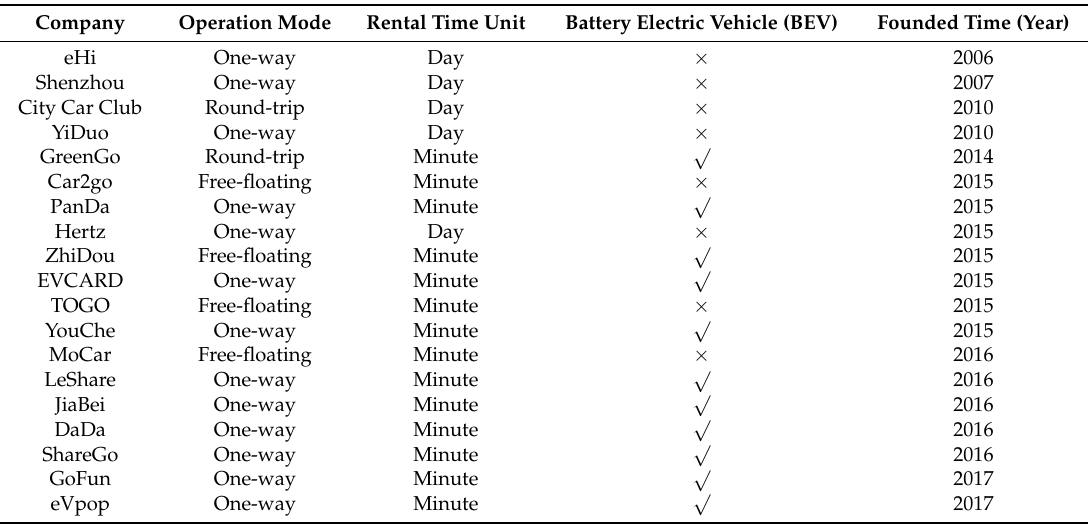
Table 1. Basic information about carsharing development in